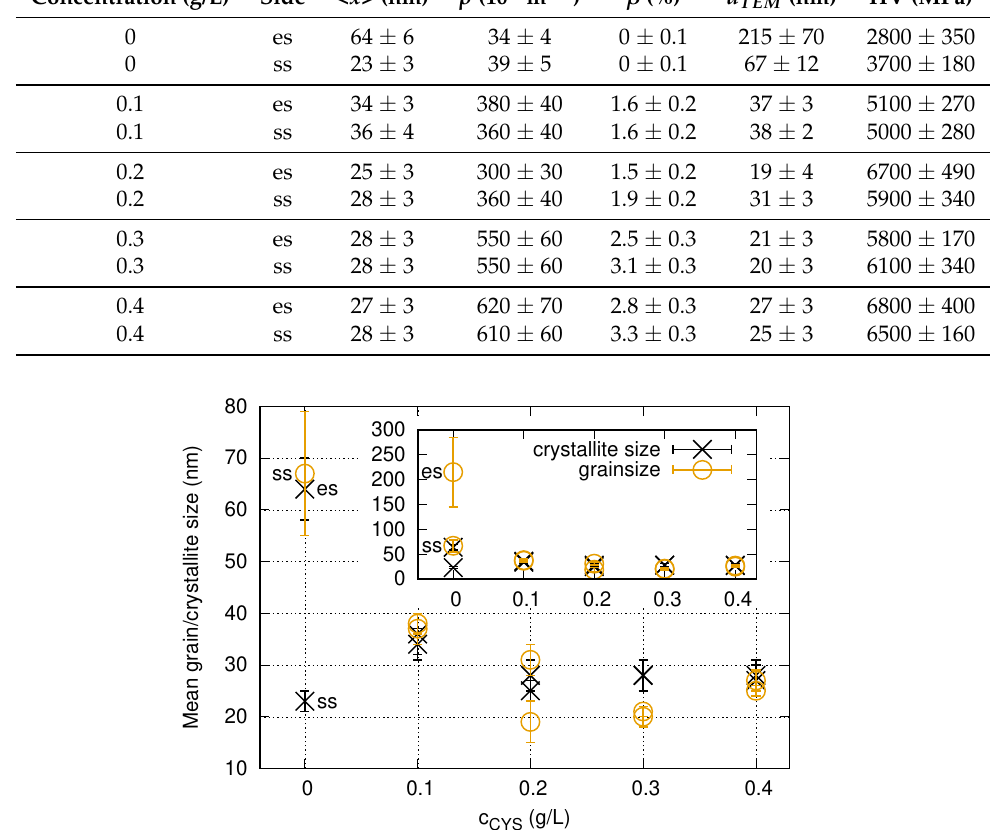
Figure 2. Grain size determined by TEM and crystallite size obtained by XLPA for the “es” and “ss” sides of the films versus the cysteine content of the bath. Subfigure was inserted to reveal the details of the figure without the outlier data point corresponding to the grain size of the electrolyte side of sample